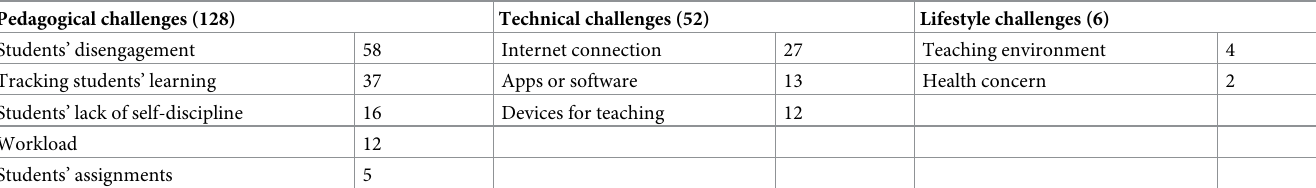
Table 7. Categories of challenges reported by teachers (codes and